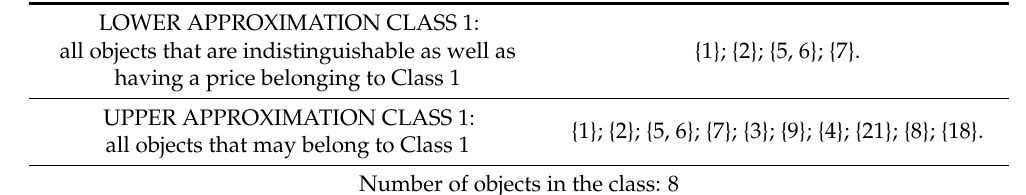
Table 5. Lower and upper approximations for Price Class 1.